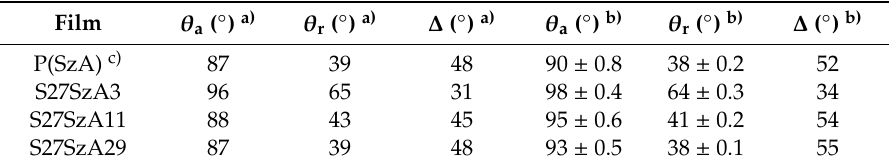
Advancing and receding contact angles for S27SzAn block copolymers and the